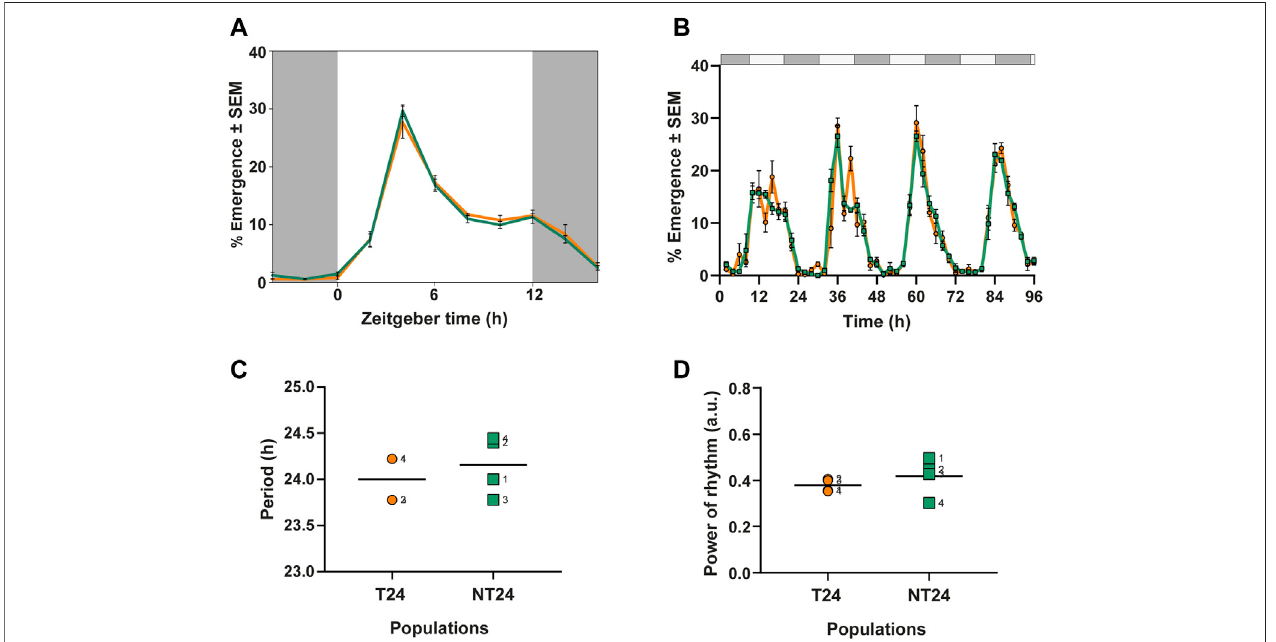
FIGURE2| Eclosionrhythmunderstandardlaboratoryconditionsandconstantconditions. (A) Eclosionpro fi lesforNT24(green)andT24(orange)plottedasdaily averagepercentageoftotalindividuals,averagedacross10replicatevialsunderLD(12:12),25 ° C,~70%RH (B) TimeseriesofdailypercentageemergenceforNT24and T24populationsunderconstantdarkness(DD),Errorbars=SEM (C) Free-runningperiod(autocorrelation)underDD (D) Powerofrhythm(autocorrelation)underDD.For (C,D) individual points represent independent replicate populations, dashed line represents mean, Two-Way ANOVA, p > 0.05.